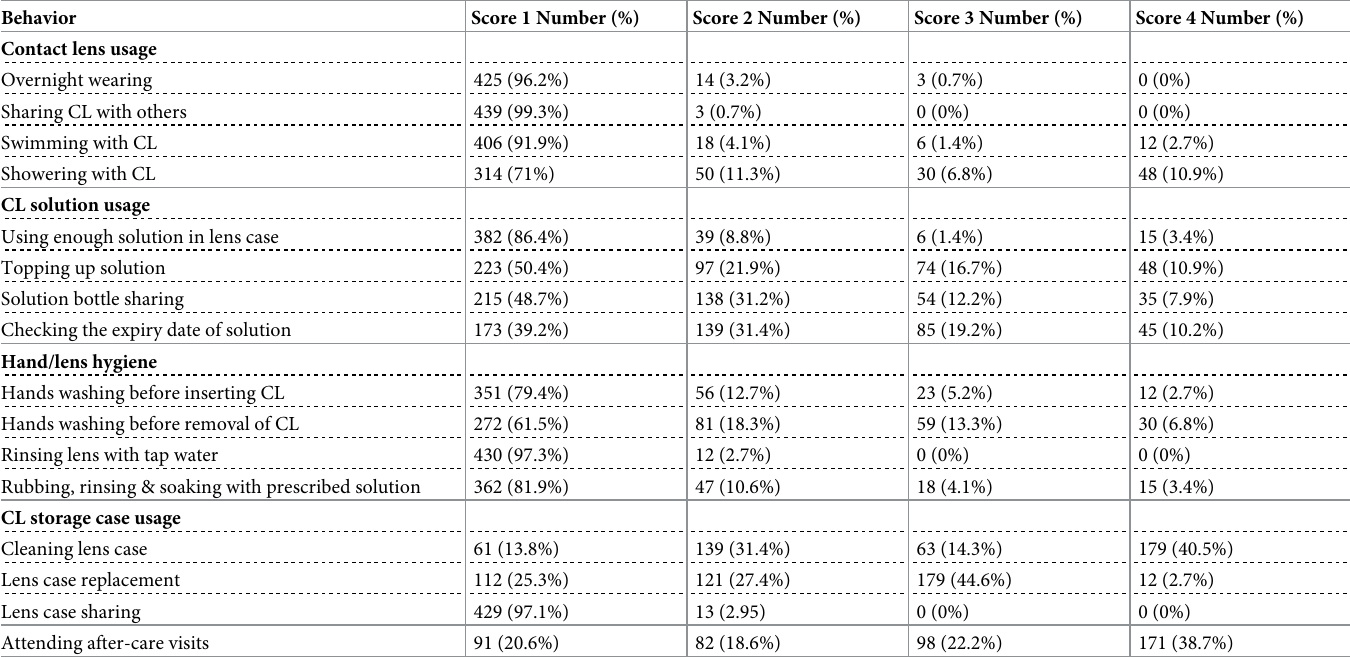
Table 3. Level of compliance to behaviors related to contact lens (CL) wear as reported by study’s participants (n = 442).